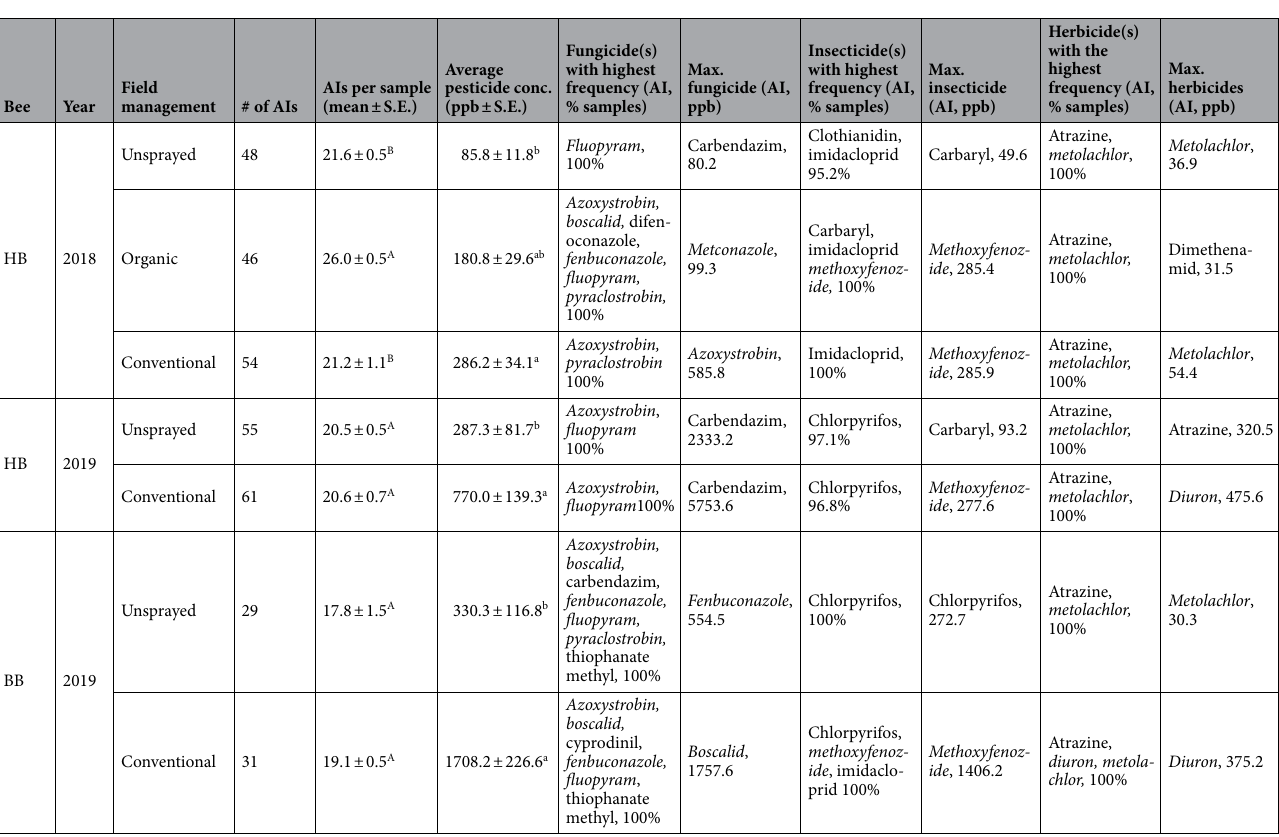
Table 1. Summary table of pesticide detections from pollen collected from honey bees (HB) or bumble bees (BB) on blueberry farms in 2018 and 2019. Number of active ingredients (AIs) detected includes all AIs detected within a farm type (unsprayed, organic, or conventional) in each year. Average AIs and pesticide concentrations were calculated by averaging the totals between individual samples. Maximum detections are the highest detections of AIs within each group of samples. AIs in italics are registered for use in highbush blueberry during bloom. Superscript letters indicate significant differences within a year/bee